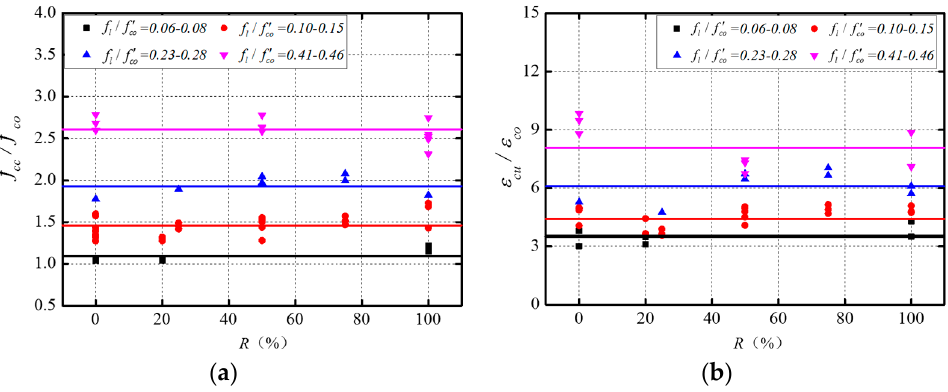
Figure 7. Influence of the replacement ratio of RAs. ( a ) Strength gain ratio vs. replacement ratio; ( b ) strain gain ratio vs. replacement